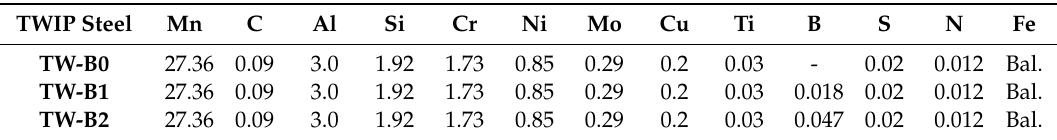
Table 1. Chemical composition of studied low-carbon highly alloyed twinning-induced plasticity (TWIP) steels (in